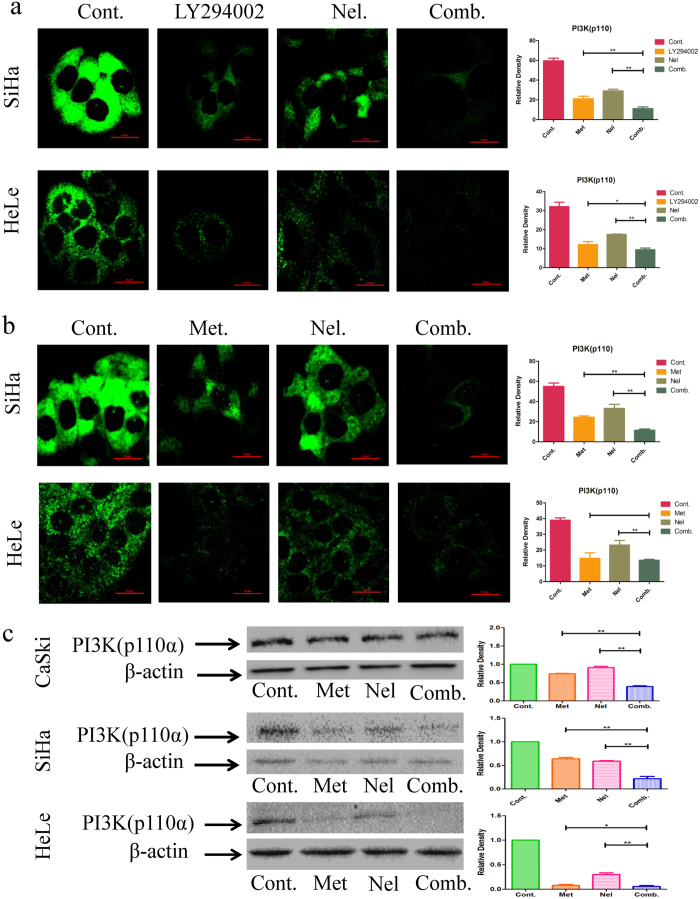
The effects of metformin (LY294002 as a control) and nelfinavir, alone or in combination, on cancer-related proteins PI3K(p110α).SiHa, HeLa and CaSki cells were treated with 10 mM metformin or 50 μM LY294002 or 4 μM nelfinavir, alone or in combination, for the indicated times. Antibodies against PI3K were used. (a,b) The expression of PI3K(p110α) was measured by confocal microscope. (c) The expression of PI3K(p110α) was measured by Western blot. Each sample was tested in triplicate and data are shown as means ± SEM. Values are expressed as the fold change of untreated control at the indicated time point. *p < 0.05, **p < 0.01, compared to untreated control or individual drug (Cont, control; Met, metformin; Nel, Nelfinavir; Comb, the combination of metformin and nelfinavir).